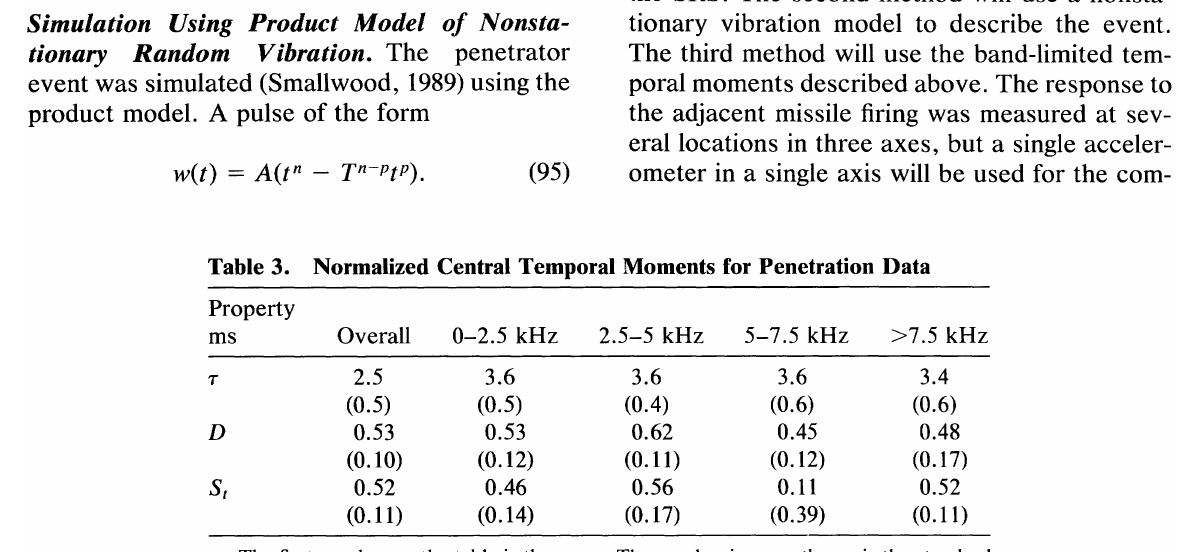
Table 3. Normalized Central Temporal Moments for Penetration Data